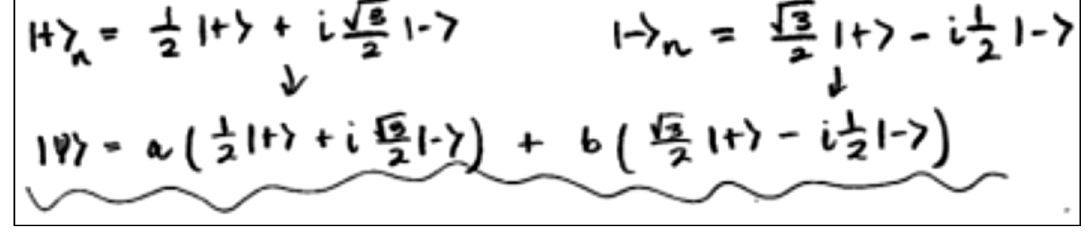
FIG. 3. Student work showing an alternative correct method for finding the representation of a state in a different basis. In this method, the student substitutes the new basis states into the generic representation. Subsequent combining of like terms allows the student to compare the expression to the original state and solve for a and b .